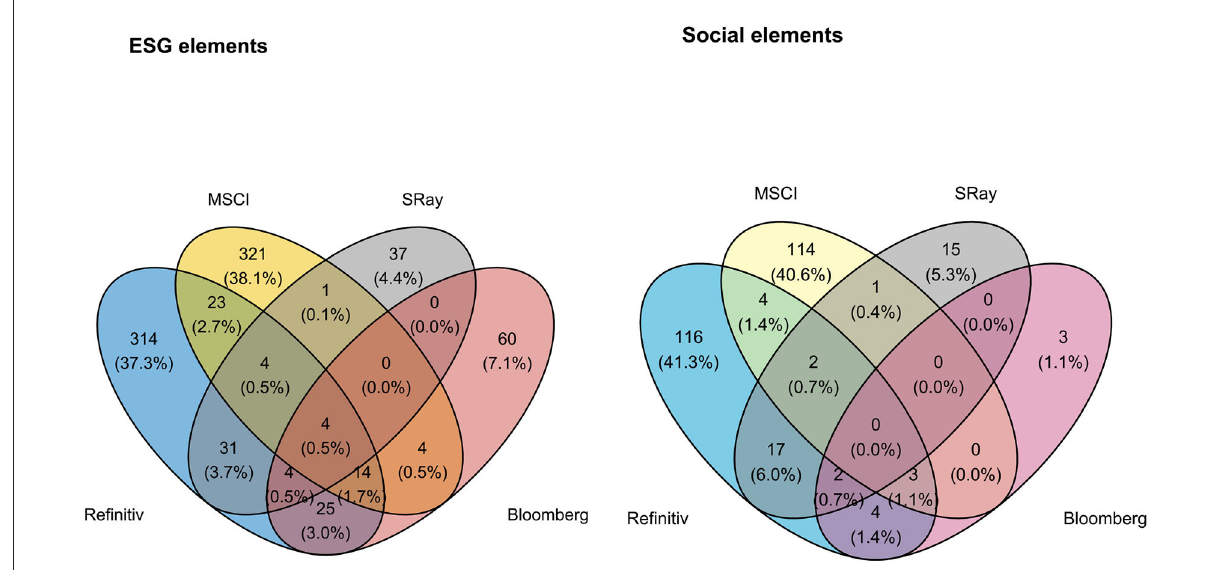
FIGURE9 Comparison of evaluated factors across ESG